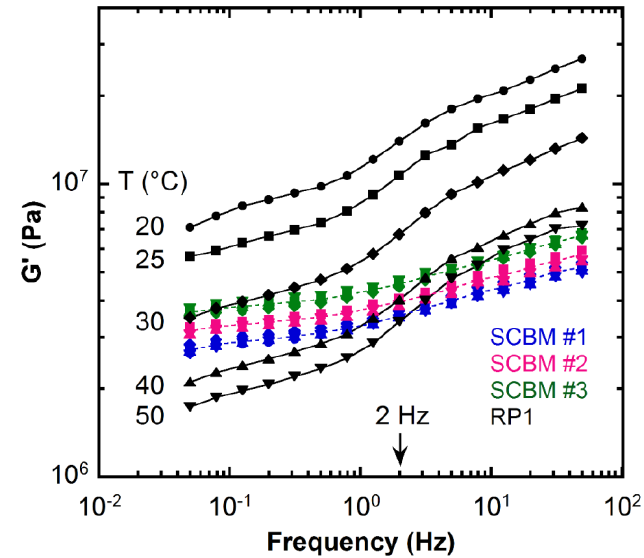
Figure 1. Dynamic shear storage modulus ( G ’ ) as a function of frequency measured at a strain of 0.14% (within the linear range) at different temperatures ranging from 20 ◦ C to 50 ◦ C for the SCBM materials and the RP1 clay [11]. The data points are color-coded based on different materials: blue—SCBM #1; pink—SCBM #2; green—SCBM #3; black—RP1 clay. Different symbols represent data points at different temperatures for each material: circle • —20 ◦ C; square (cid:4) —25 ◦ C; diamond (cid:7) —30 ◦ C; up-pointing triangle (cid:78) —40 ◦ C; down-pointing triangle (cid:72) —50 ◦ C. The solid lines for the RP1 clay are guides for the eye. The dashed lines are average G ’ values from different temperatures for the SCBM materials. The measurement uncertainty is 3%. View in color for best clarity. Table 1. The shear storage modulus ( G ’) at 2 Hz for the silicone composite backing materials (SCBMs) and Roma Plastilina No. 1 (RP1) from frequency sweep experiments at different temperatures.